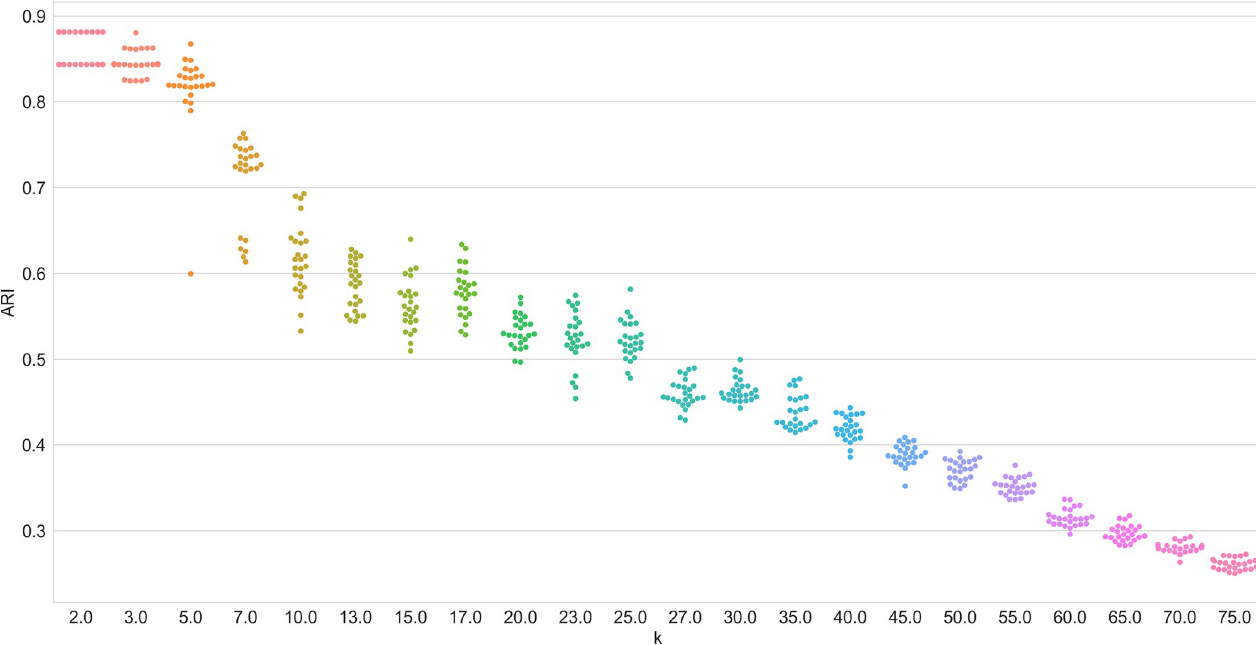
PLOS ONE | https://doi.org/10.1371/journal.pone.0266325 April 28,